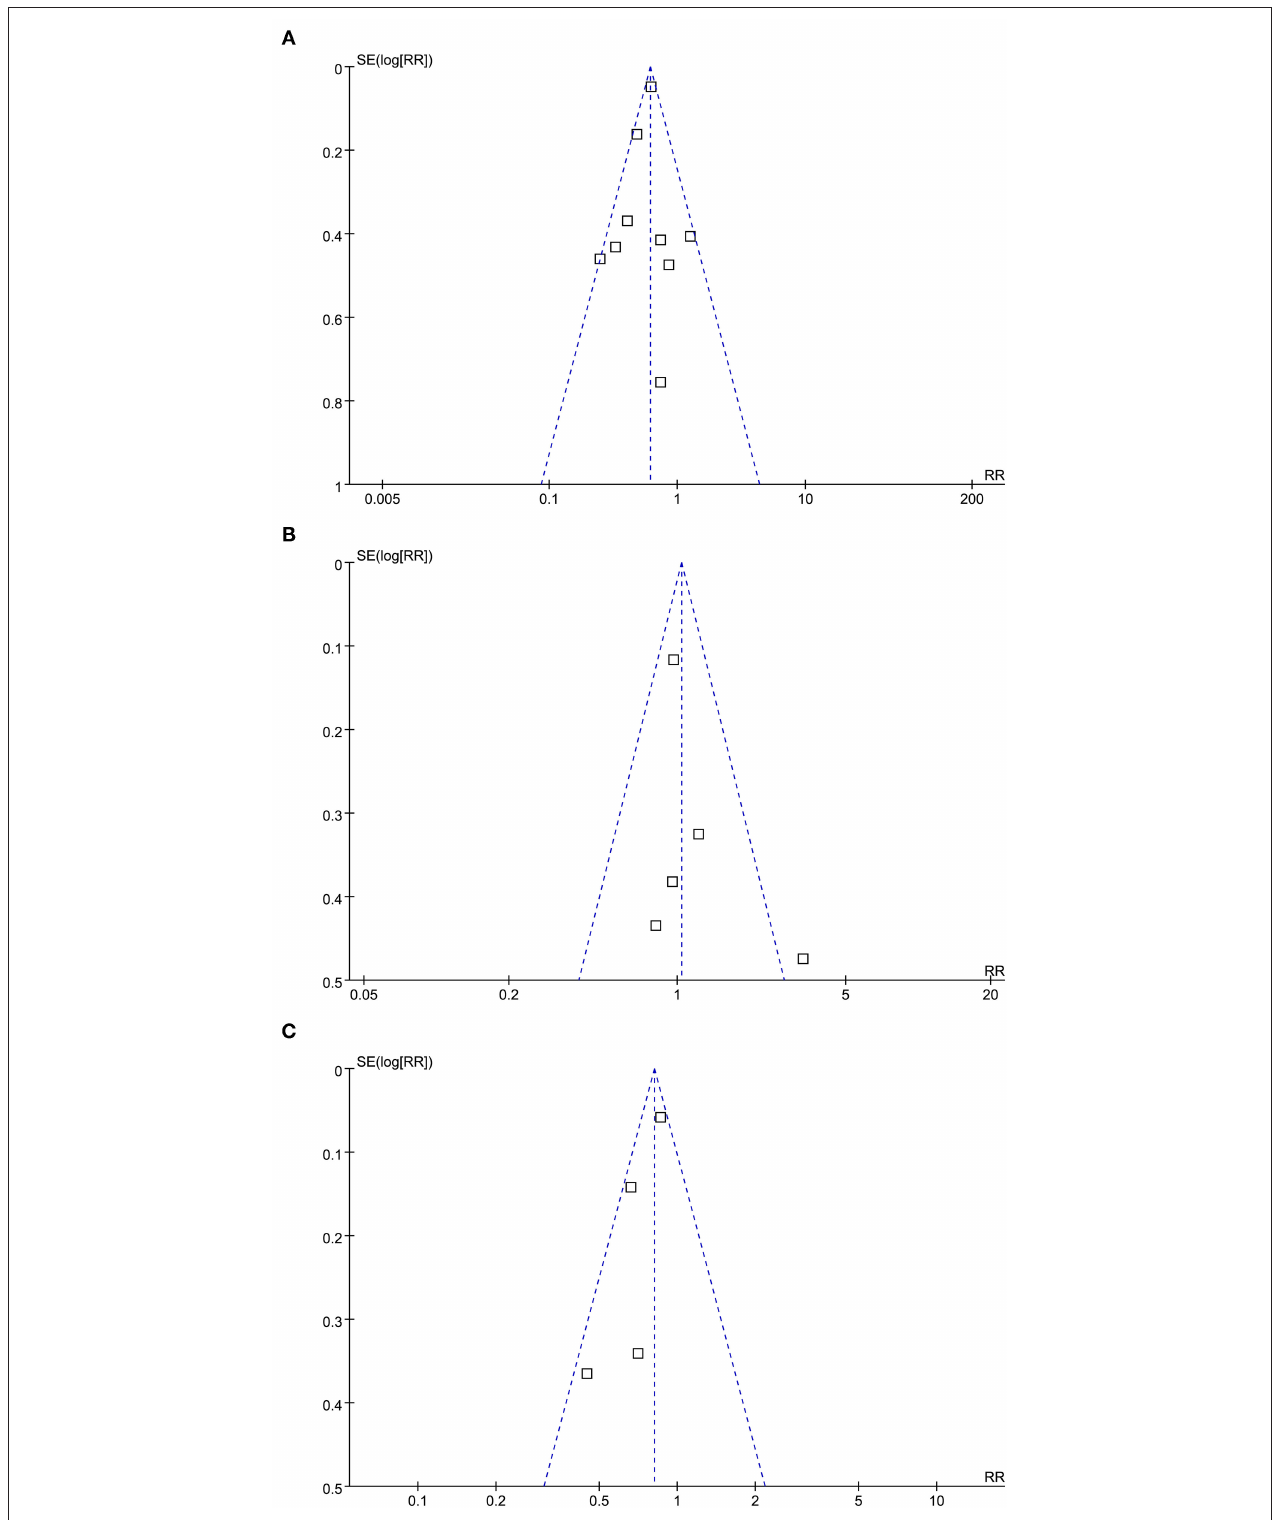
FIGURE 3 | Funnel plots for the meta-analyses of the association between statin use and clinical outcomes in PLWH; (A) funnel plots for the meta-analysis of all-cause mortality; (B) funnel plots for the meta-analysis of CV events; and (C) funnel plots for the meta-analysis of incidence of cancer.